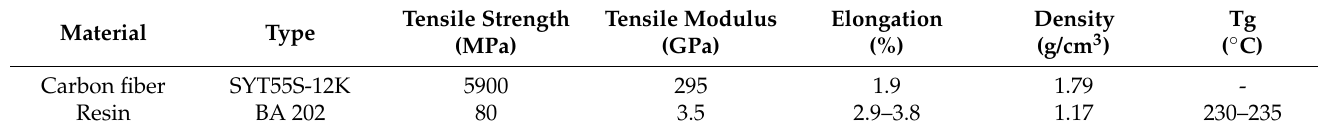
Table 1. Properties of component materials for unidirectional CFRP plate specimens.